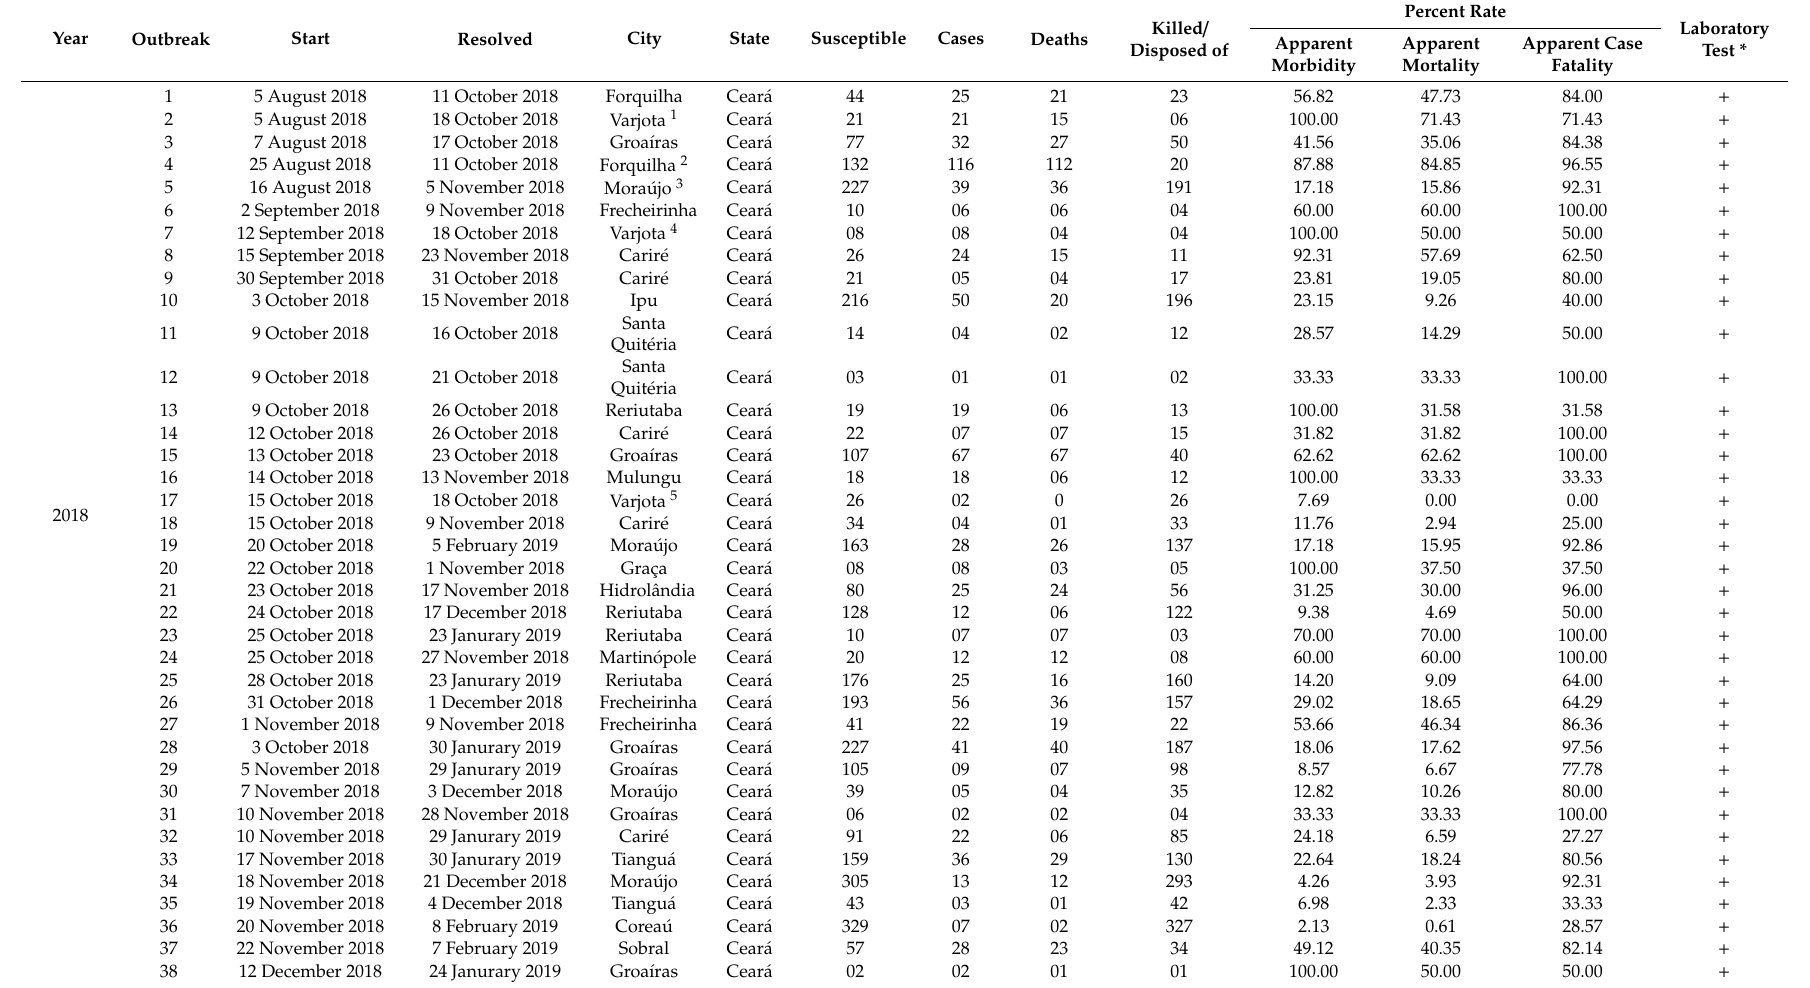
Table 2. Classical swine fever outbreaks in the non-free zone from 2018 to 2019 in